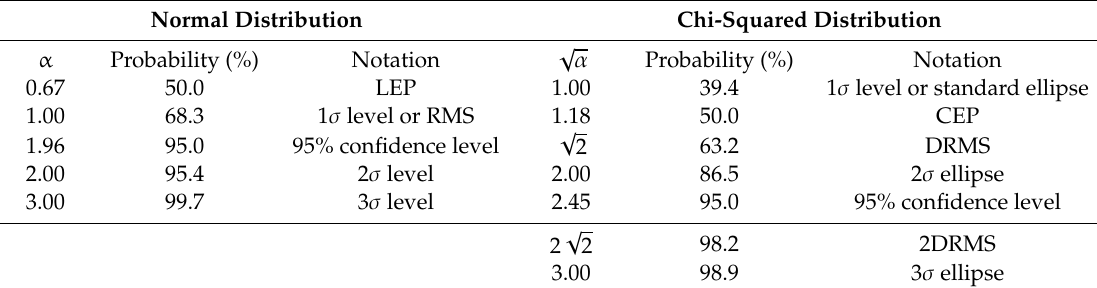
Table 1. Relationship between the population and probability in normal as well as chi-squared distributions. Normal